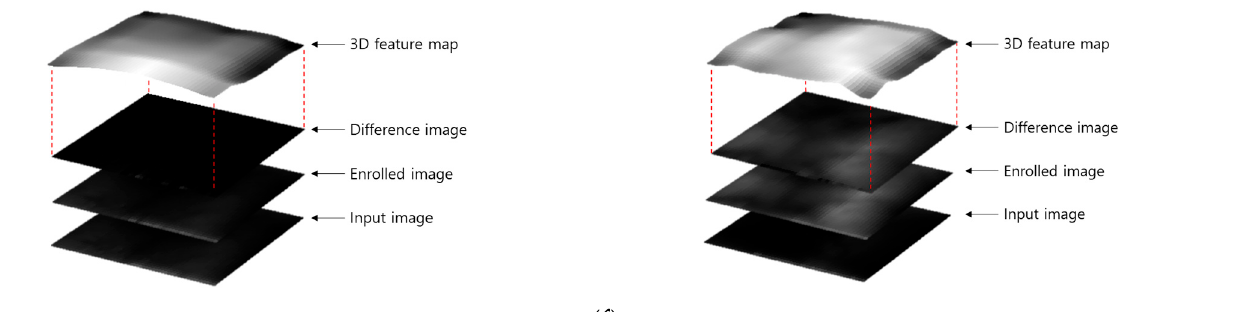
Figure 22. Feature maps extracted from a genuine matching image and an imposter matching image from several layers of the DenseNet-161. ( a ) Feature maps from the 1st convolutional layer; ( b ) feature maps from the 1st transition layer; ( c ) feature maps from the 2nd transition layer; ( d ) feature maps from the 3rd transition layer; ( e ) feature maps from the last dense block, and ( f ) 3D feature maps created by averaging feature map values of ( e ). Upper and lower examples in ( a – f ) represent genuine matching feature maps and imposter matching feature maps, respectively.